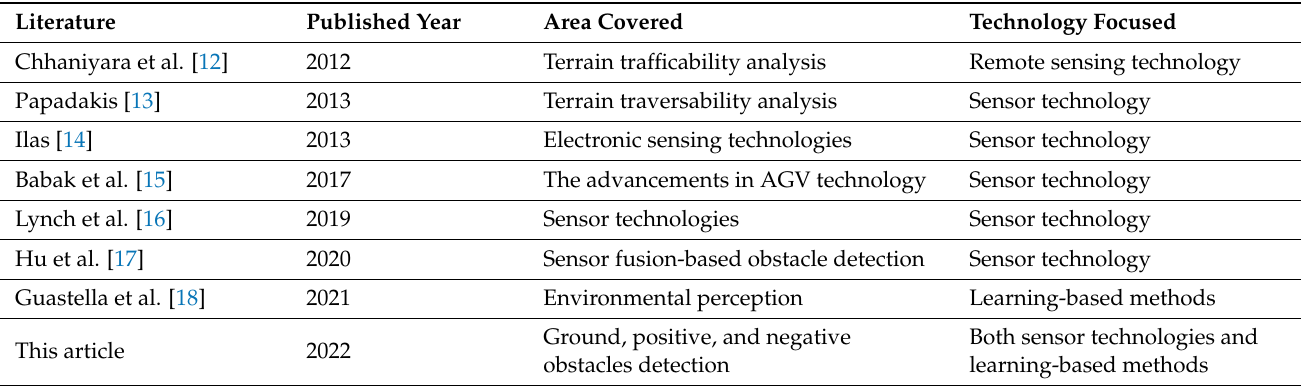
Table 1. The existing review works that have covered the mobility of AGV in off-road environments, including this